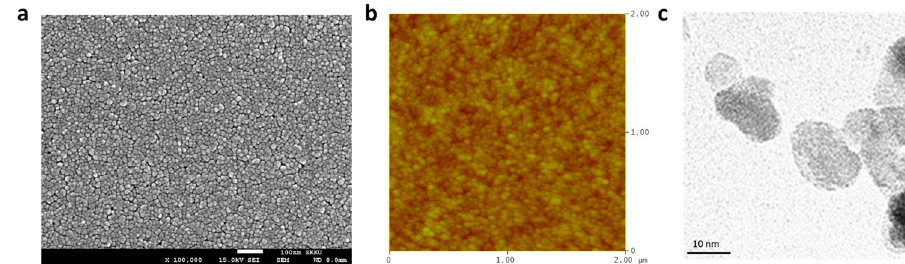
Figure 5. ( a ) SEM image of a ZnO layer on ITO, ( b ) AFM image of a ZnO layer on ITO, and ( c ) TEM image of ZnO